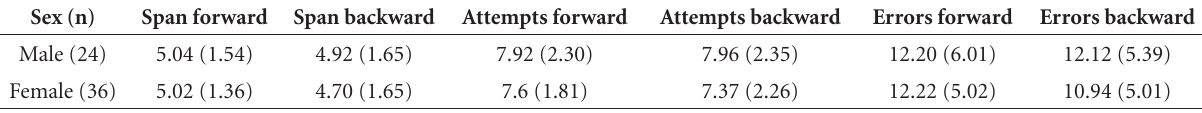
Table 2. Performance by gender.